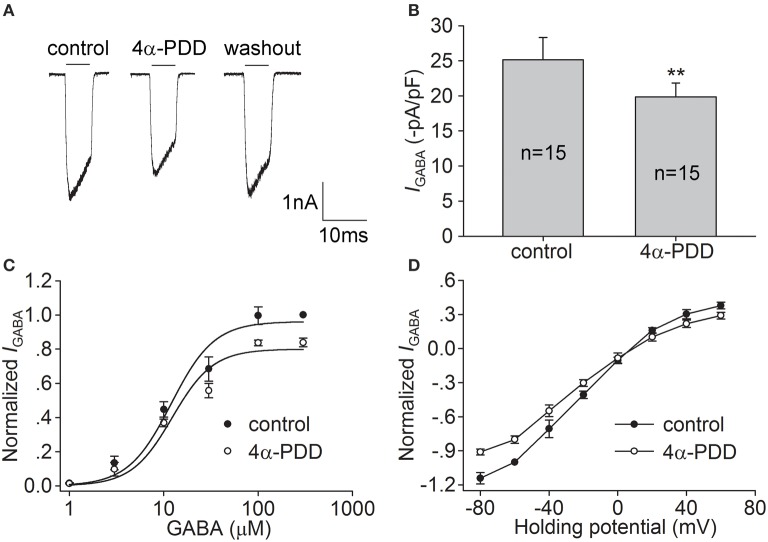
Effect of 4α-PDD on IGABA in hippocampal CA1 pyramidal neurons. (A,B)
IGABA (activated by 10 μM GABA) was inhibited by 10 μM 4α-PDD. The representative recordings show that IGABA was −3.0, −2.4, and −2.9 nA before, during and after 4α-PDD treatment, respectively (A). On the average, IGABA was reduced from −25.2±3.2 to −19.9±1.9 pA/pF. **P < 0.01 vs. control (B). (C) Dose-response curves for IGABA before and during 4α-PDD treatment. Each point represents the normalized current from 7 to 10 neurons. (D) I–V curves for IGABA before and during 4α-PDD treatment. Each point represents the normalized current from 7 to 10 neurons.